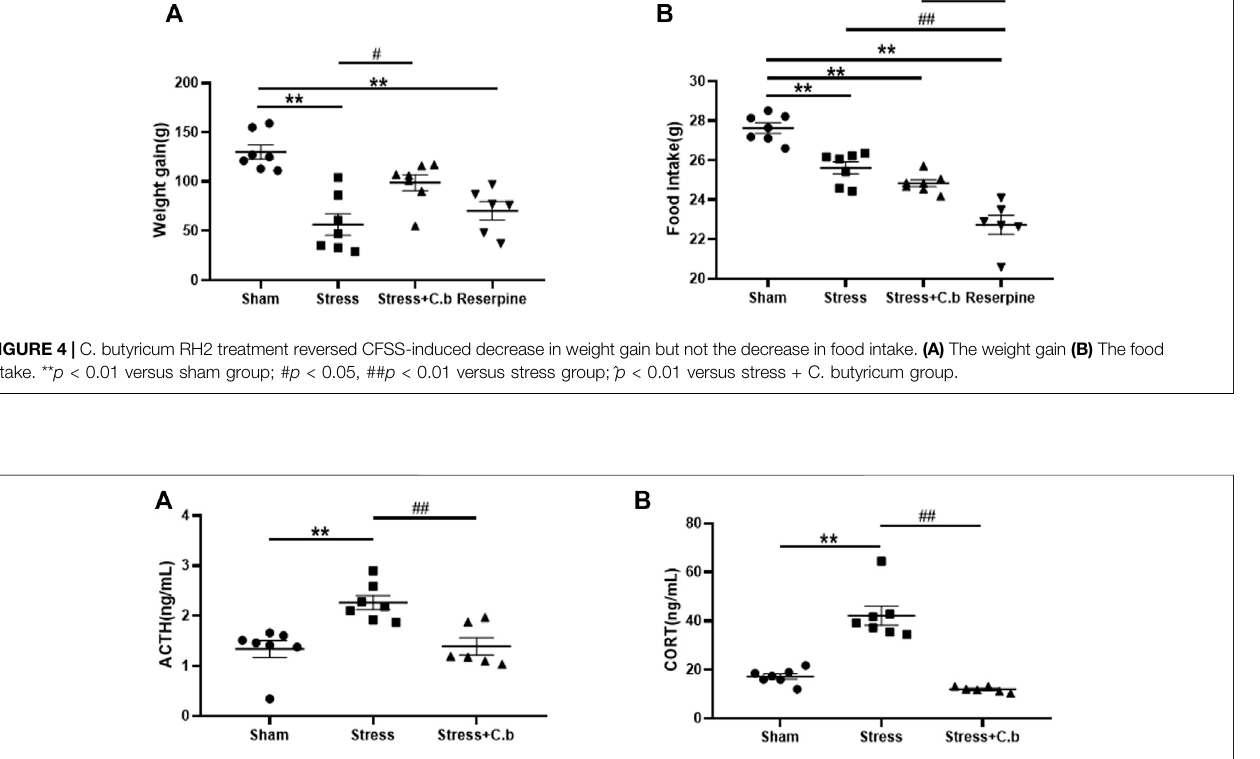
FIGURE 5 | C. butyricum RH2 treatment reversed CFSS-induced decreases in serum ACTH and CORT. (A) The ACTH (B) The CORT. ** p < 0.01 versus sham group; ## p < 0.01 versus stress group.